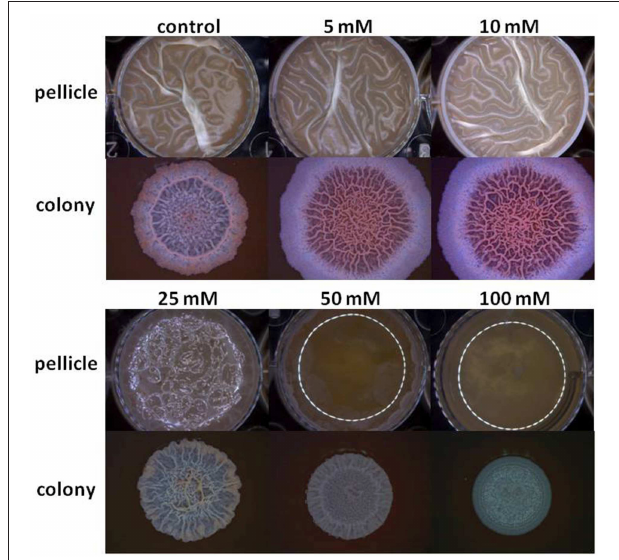
FIGURE 1 | Mg 2 + ions block biofilm formation of B. subtilis . The effect of addition of different concentrations of MgCl 2 to LBGM medium on pellicle and colony biofilm formation by B. subtilis